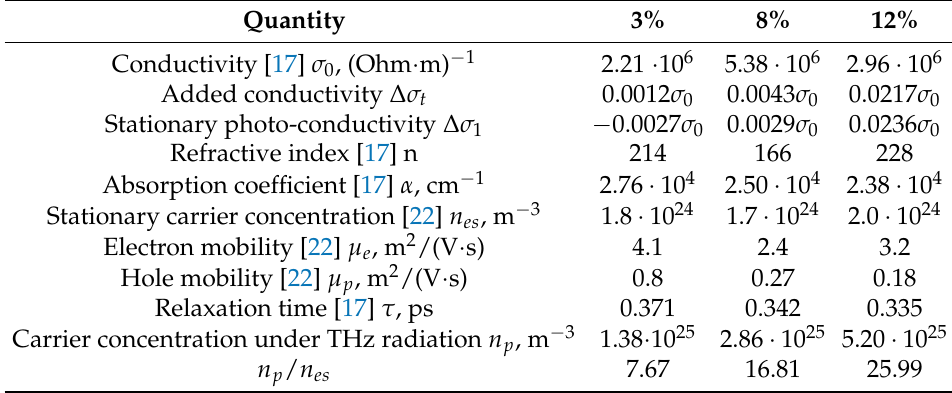
Table 1. Extracted material